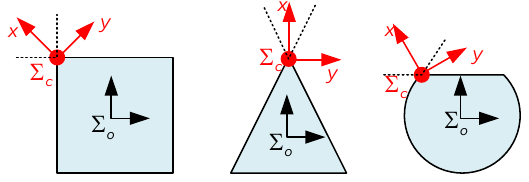
Figure 1. The peg with discontinuous curvature.